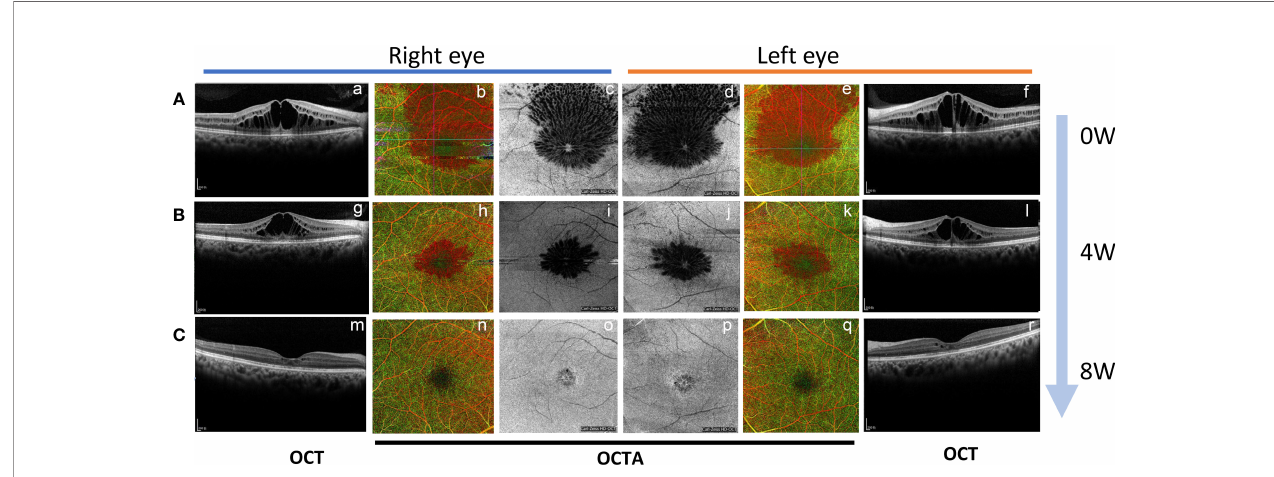
FIGURE 3 | The change of macular edema by B-scan and en face optical coherence tomography and OCTA during the time course. (A) The OCT B-scan (a, f), OCTA (b, e), and en face OCT (c, d) revealed macular edema in both eyes at initial consultation; (B) One month after applying IVR (OCT B-scan g and l, OCTA h and k, en face OCT i and j); (C) One month after topical brinzolamide in both eyes. (OCT B-scan m and r, OCTA n and q, en face OCT o and p).